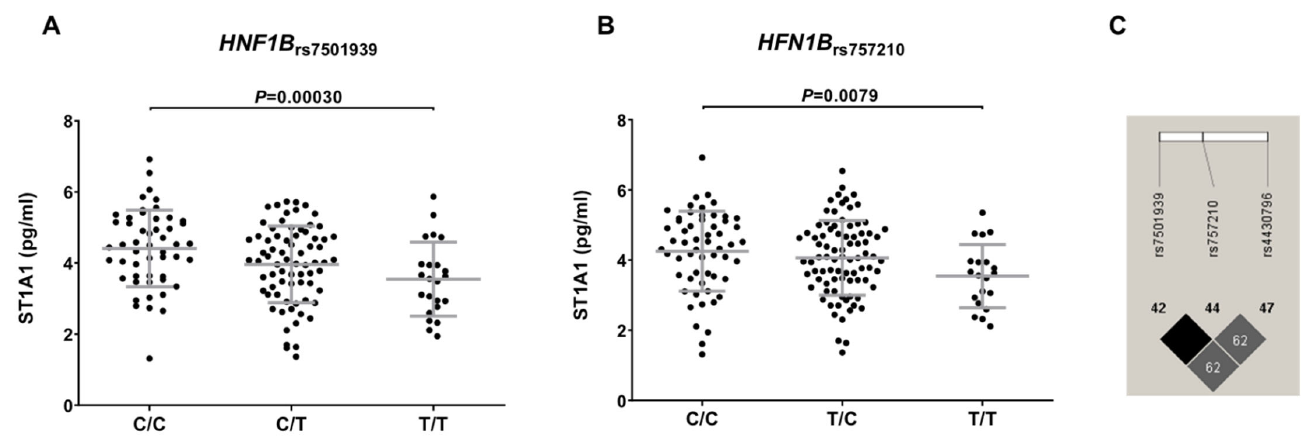
Figure 3. Correlation of the HFN1B rs7501939 ( A ) and HFN1B rs757210 ( B ) polymorphisms with reduced levels of ST1A1 protein and linkage disequilibrium values among the HFN1B SNPs included in the study ( C ). C/C, cytosine/cytosine; C/T, cytosine/thymine; T/T, thymine/thymine; T/C, thymine/cytosine